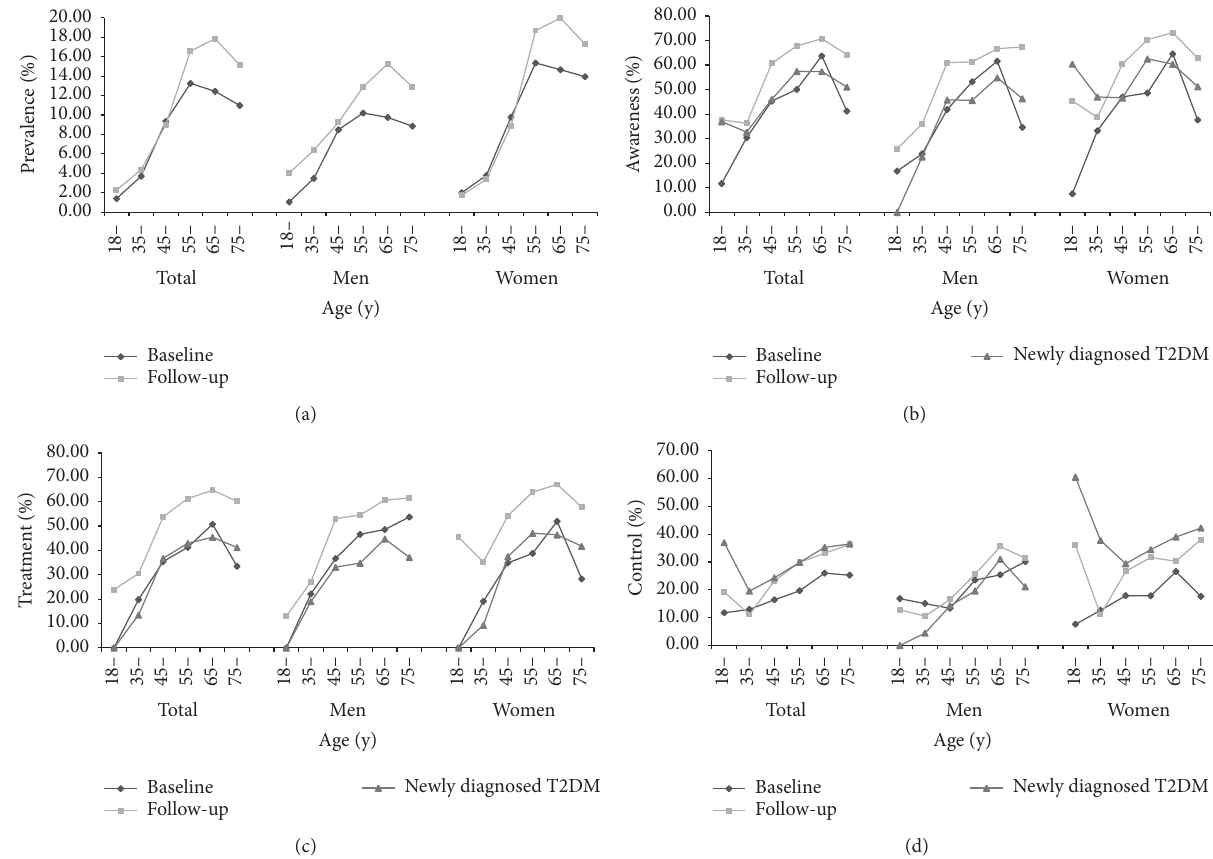
Figure 2: Trends of the age-standardized prevalence (a), awareness (b), treatment (c), and control (d) of T2DM with aging at baseline and follow-up for different genders. The trend of the age-standardized prevalence of T2DM is showed in (a), the change in the age-standardized awareness of T2DM is presented in (b), the tendency of the age-standardized treatment of T2DM is displayed in (c), and the trend of the age-standardized control of T2DM is described in the